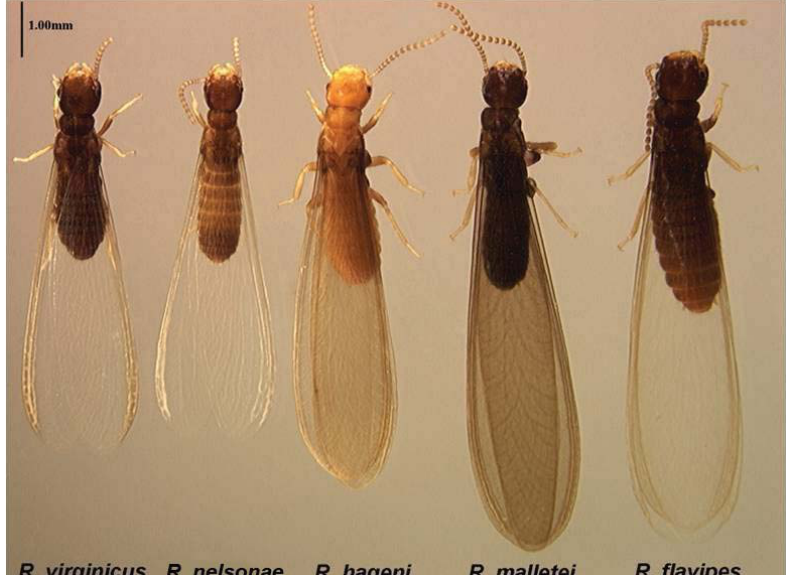
R. virginicus , R. nelsonae , R. hageni , R. malletei , R. flavipes . Scale bar = 1.00